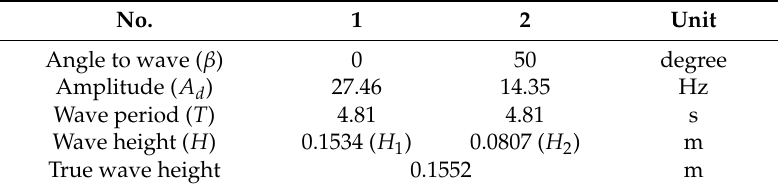
Table 8. Wave tank measurement